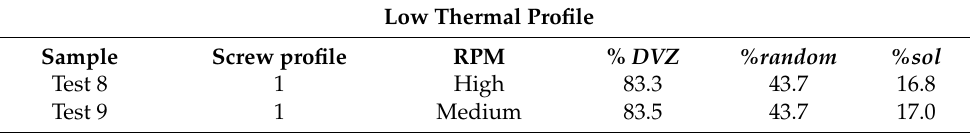
Table 5. %DVZ, %random and %sol for devulcanization carried out at low thermal profile.